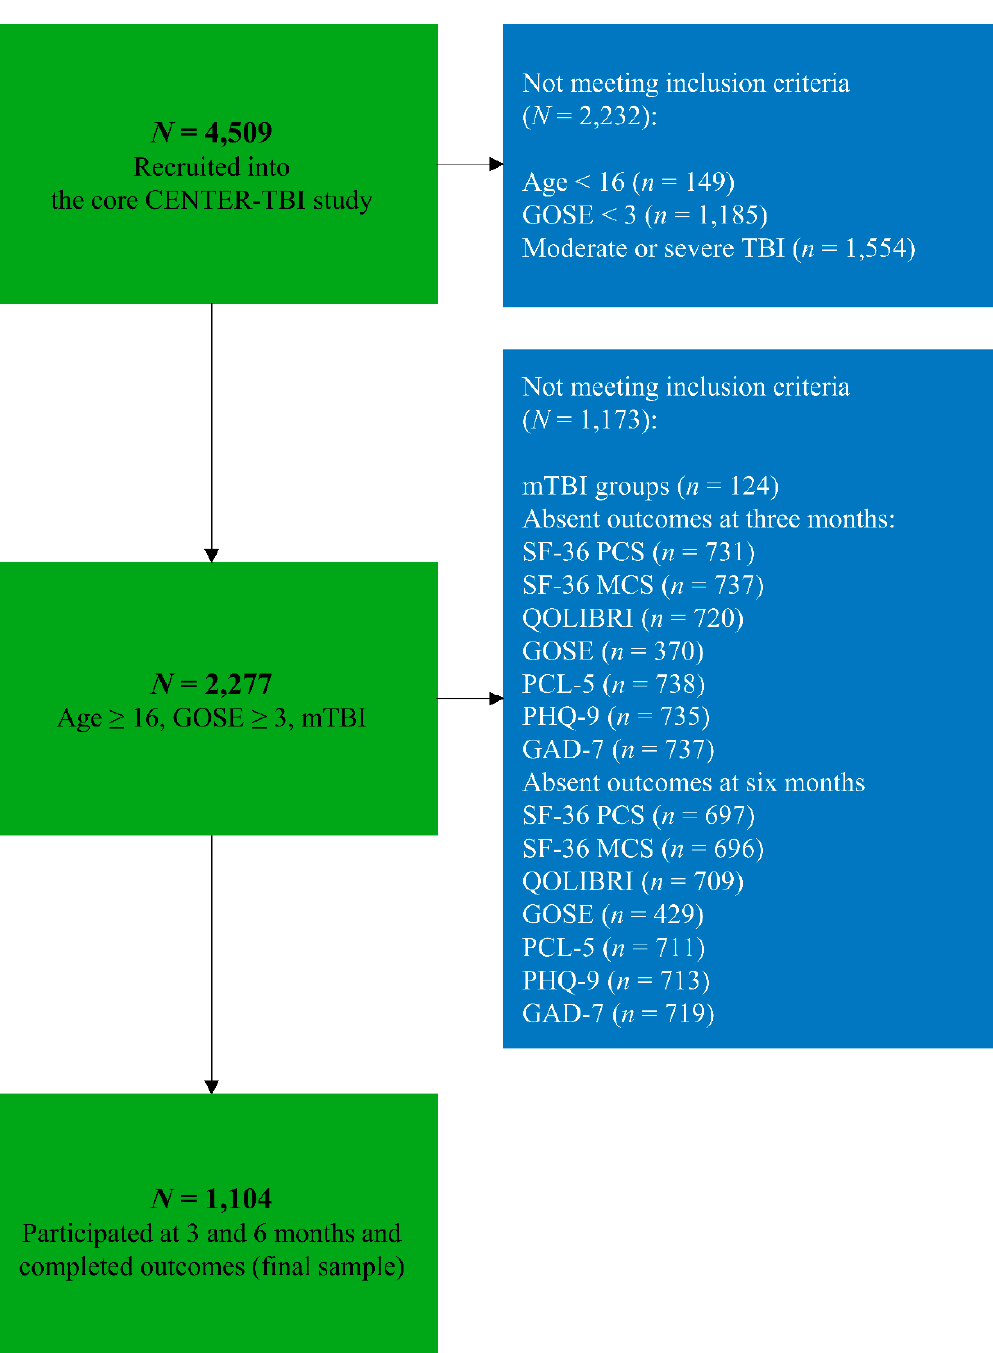
Figure 1. Flowchart sample size. Abbreviations: N = number; mTBI = mild traumatic brain